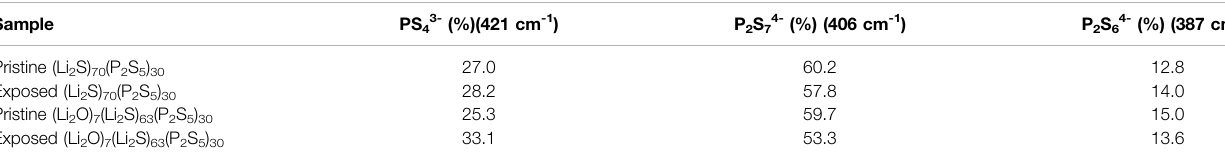
TABLE 2 | Summary of Raman spectra peak fi tting and deconvolution.